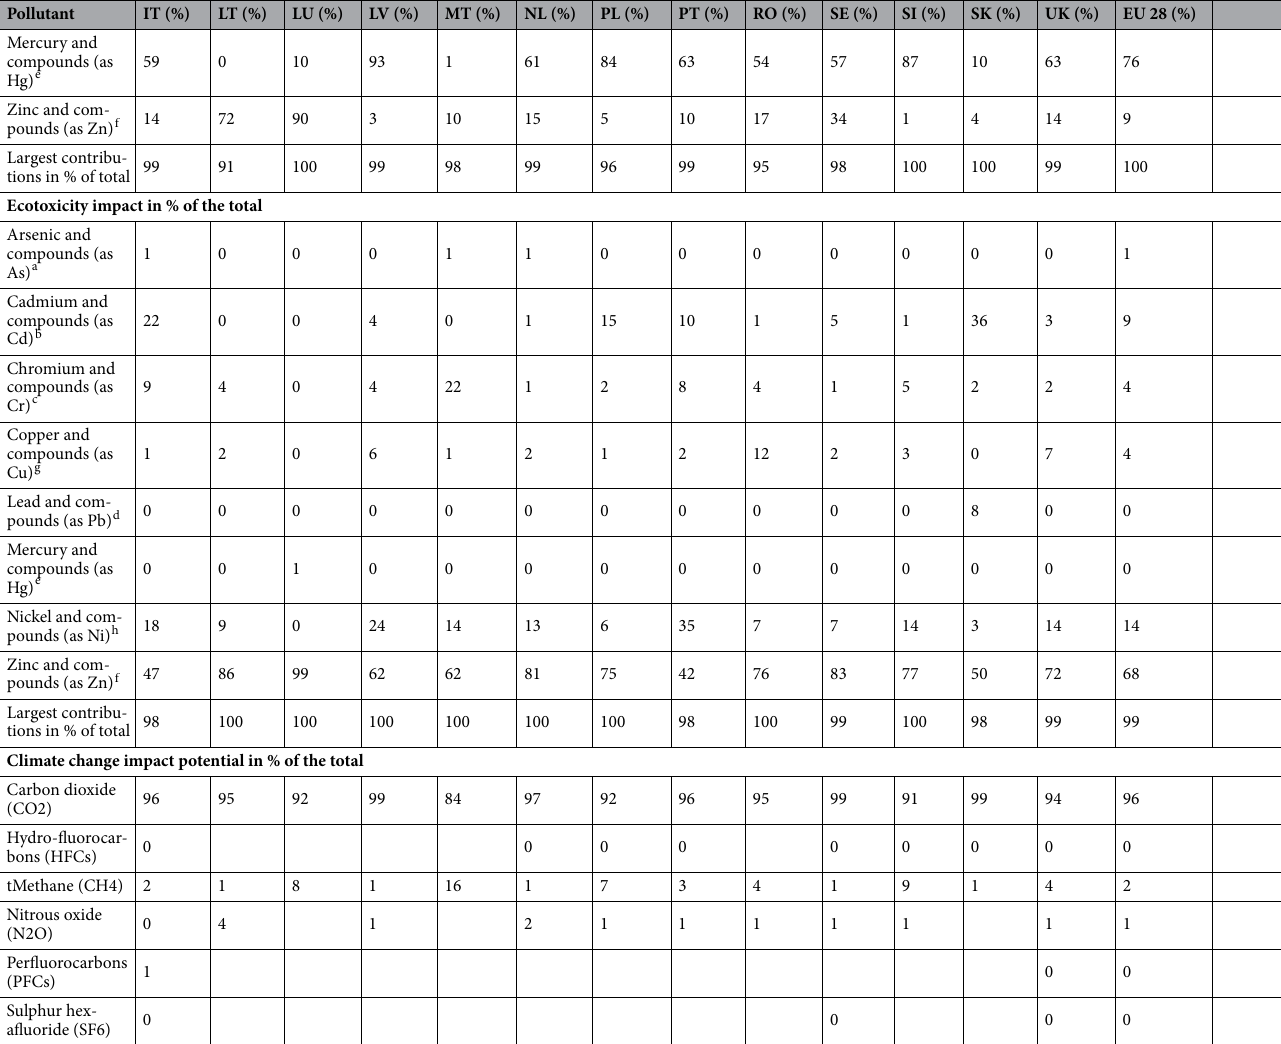
Table 2. Human toxicity, ecotoxicity and global warming impact potentials by major pollutants (in % of the total CTUh, CTUe and CO2 equivalent, respectively, 2017). This table shows the aggregated toxicity and global warming impact potentials by pollutants. The emissions in kilograms ( E ijk ) of substances (i) in the EPRTR have been multiplied by their USEtox 2.12 toxicity characterisation factors ( CF ijk ), by the global warming potential value ( GWP i ) and aggregated across all substances, release media (j) and release sub-media (k). GWP values by greenhouse-gases reported under EPRTR Methane (CH4): 25 co2eq, Carbon dioxide (CO2): 1 co2eq, Hydro- fluorocarbons (HFCs): 7462 co2eq, Nitrous oxide (N2O): 298 co2eq, Perfluorocarbons (PFCs): 9795 co2eq, a b c d e c Sulphur hexafluoride (SF6): 22800 co2eq As As(V). As Cd(II). As Cr(VI). As Pb(II). As Hg(II). As f h d e g Pb(II). As Cr(VI). As As(V). As Zn(II). As Cu(II). As